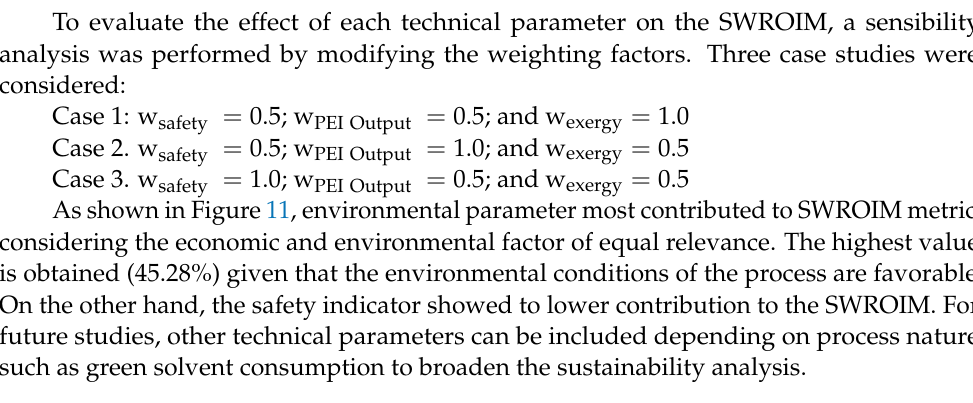
Figure 10. ROI and SWROIM for chitosan production from shrimp exoskeleton.